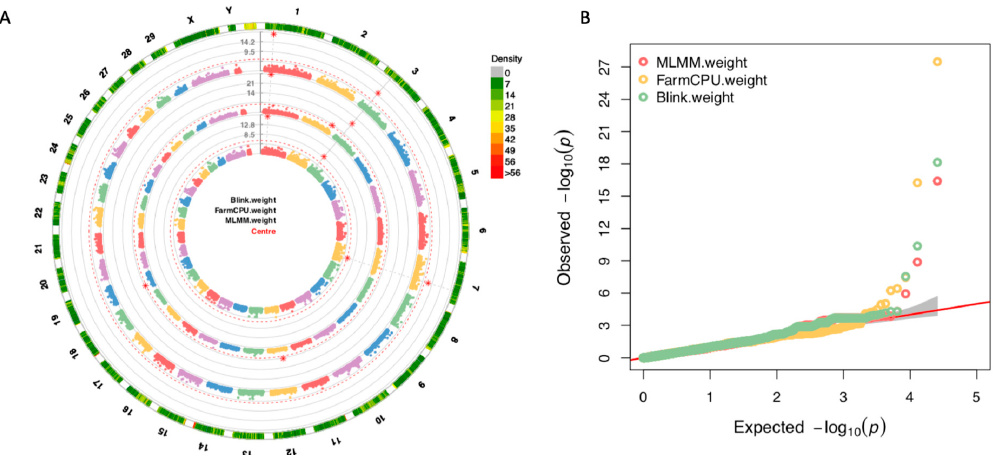
3B). A BW difference between three significant SNP genotypes were observed in the